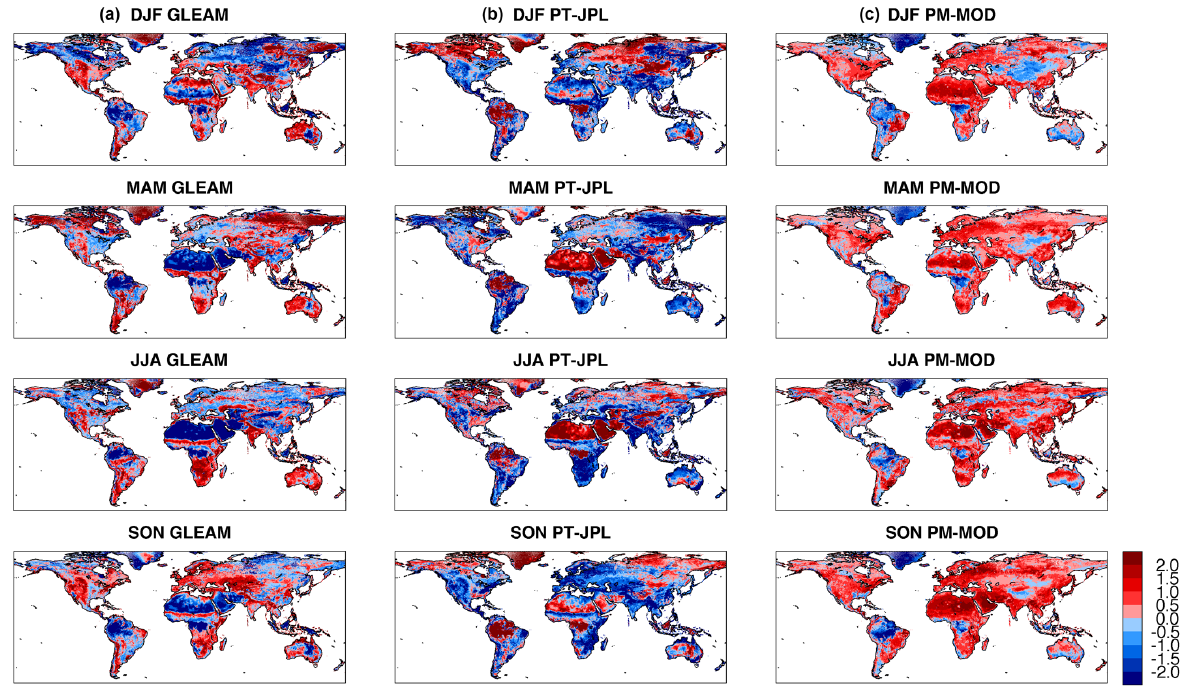
Figure 8. Seasonally averaged global weights for GLEAM (a) , PT-JPL (b) , and PM-MOD (c) . Red (blue) colours indicate positive (negative) weights.